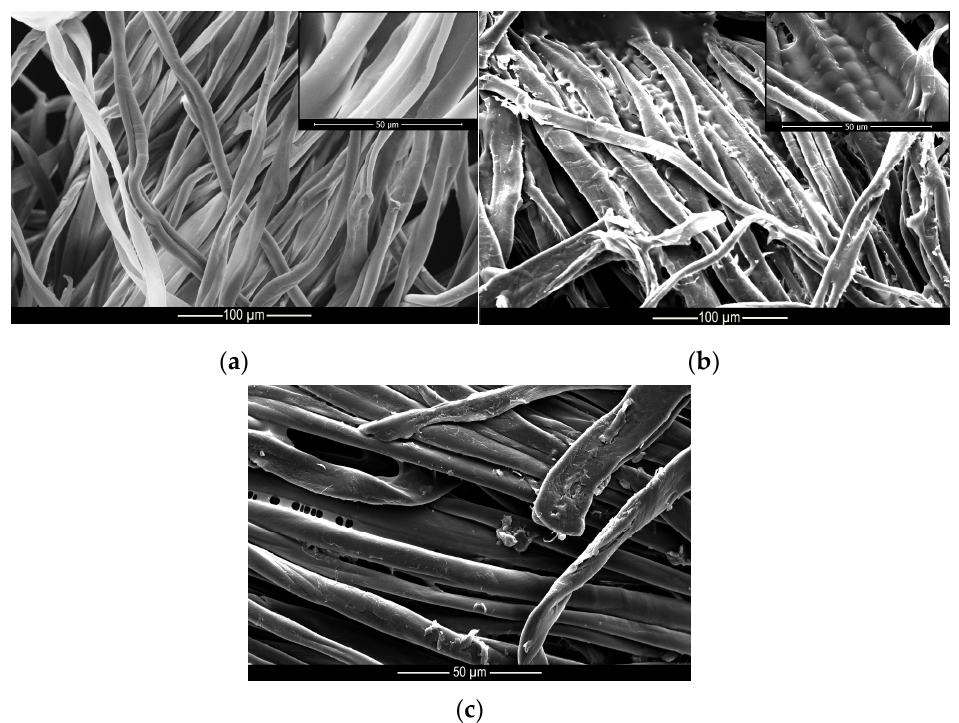
Figure 10. Microscopy of ( a ) untreated, ( b ) treated and ( c ) washed cotton